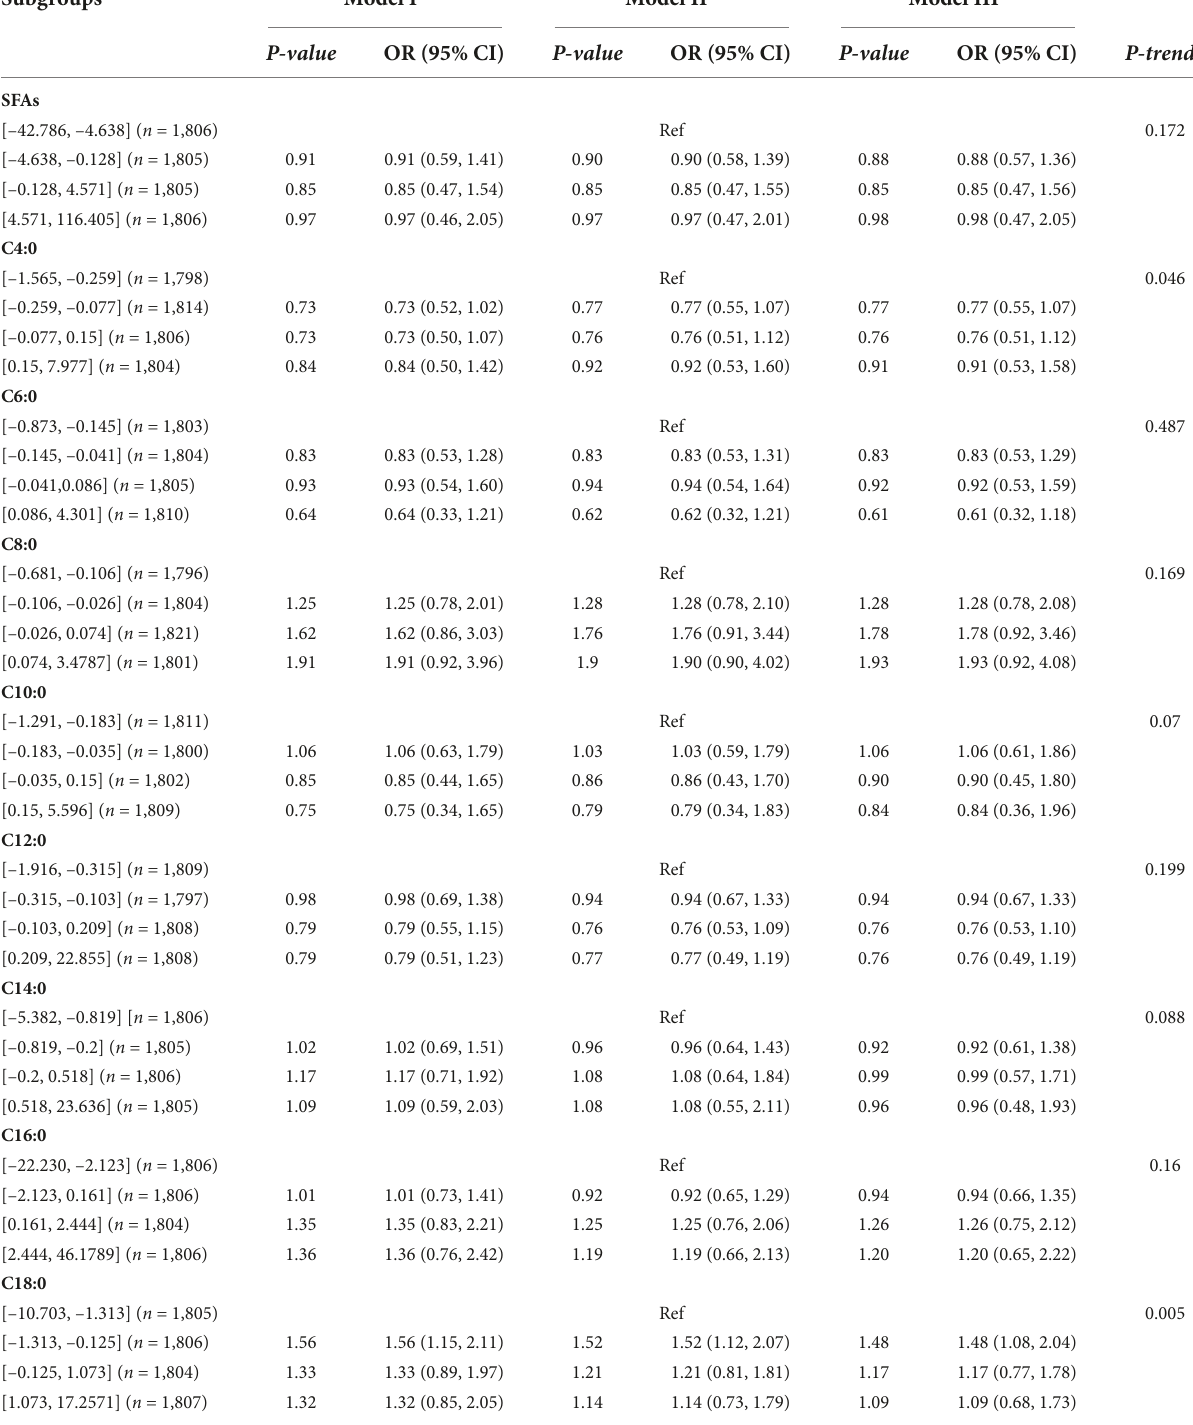
TABLE 5 Weighted odds ratio sum (95% CI) of quartiles of hypertension and adjusted dietary saturated fatty acid intake: a cross-sectional study using NHANES 1999–2018 data ( N = 7,222). Subgroups Model I a Model II